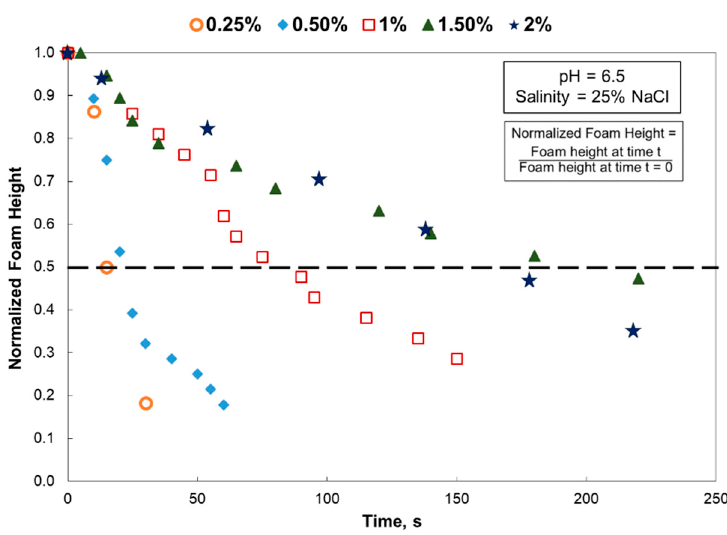
Figure 9. Effect of surfactant concentration on the foam stability at 150 °F (65 °C) and 500 psi (34.5 bar).